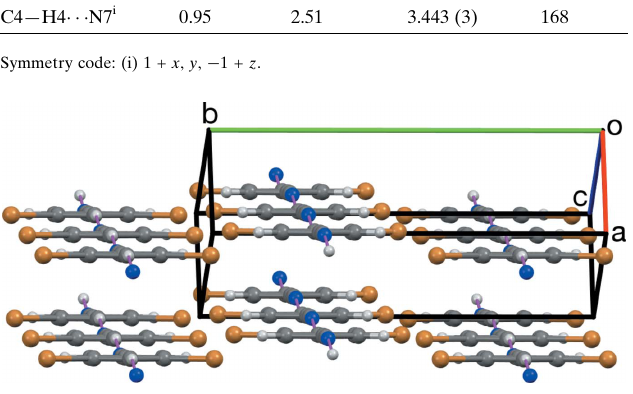
Figure 3 The arrangement of C (7) chains in the crystal of (I), viewed roughly along [101]. Dashed magenta lines represent short contacts.